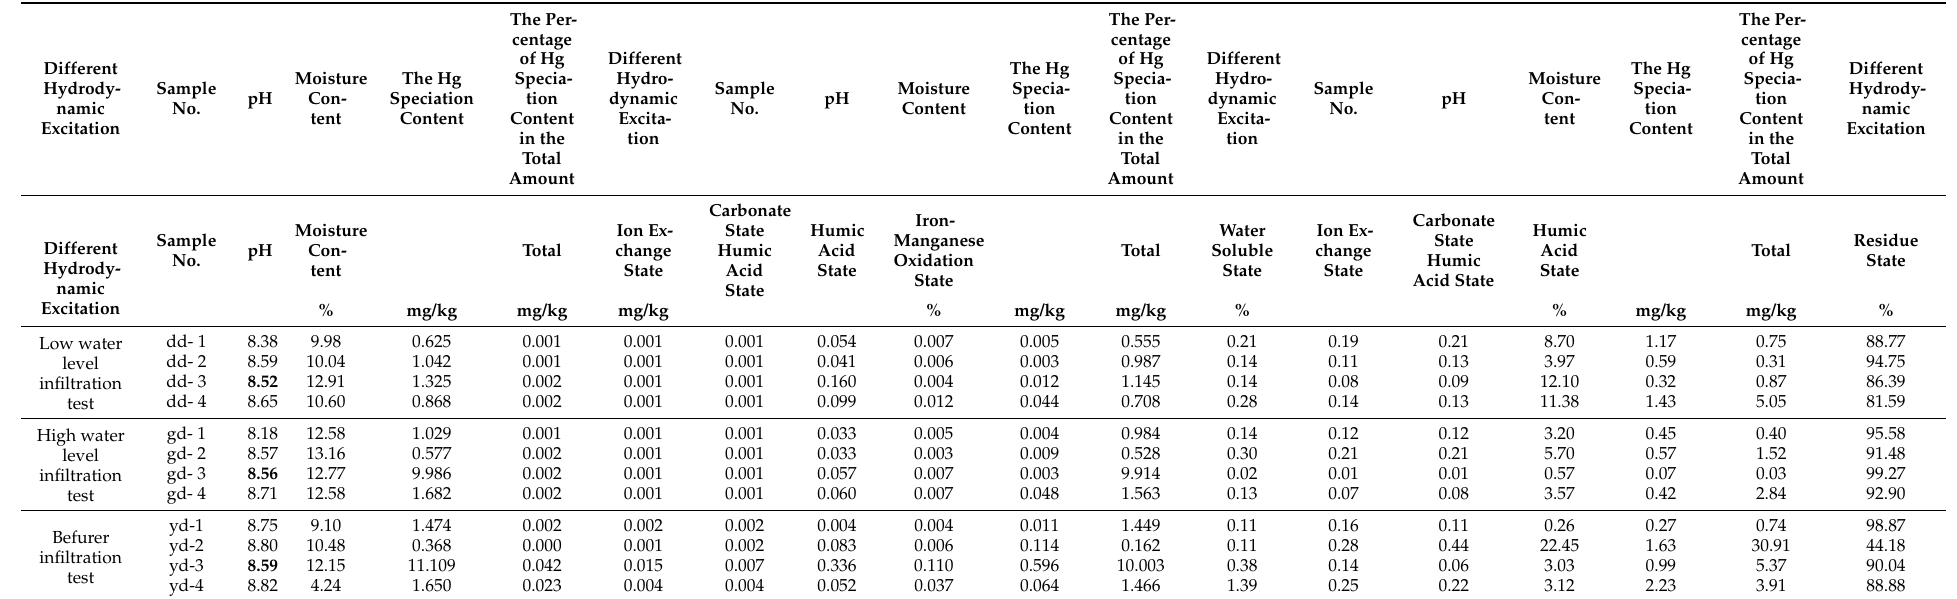
Table 4. List of mercury speciation content and its percentage in subsurface flow zone in the wet